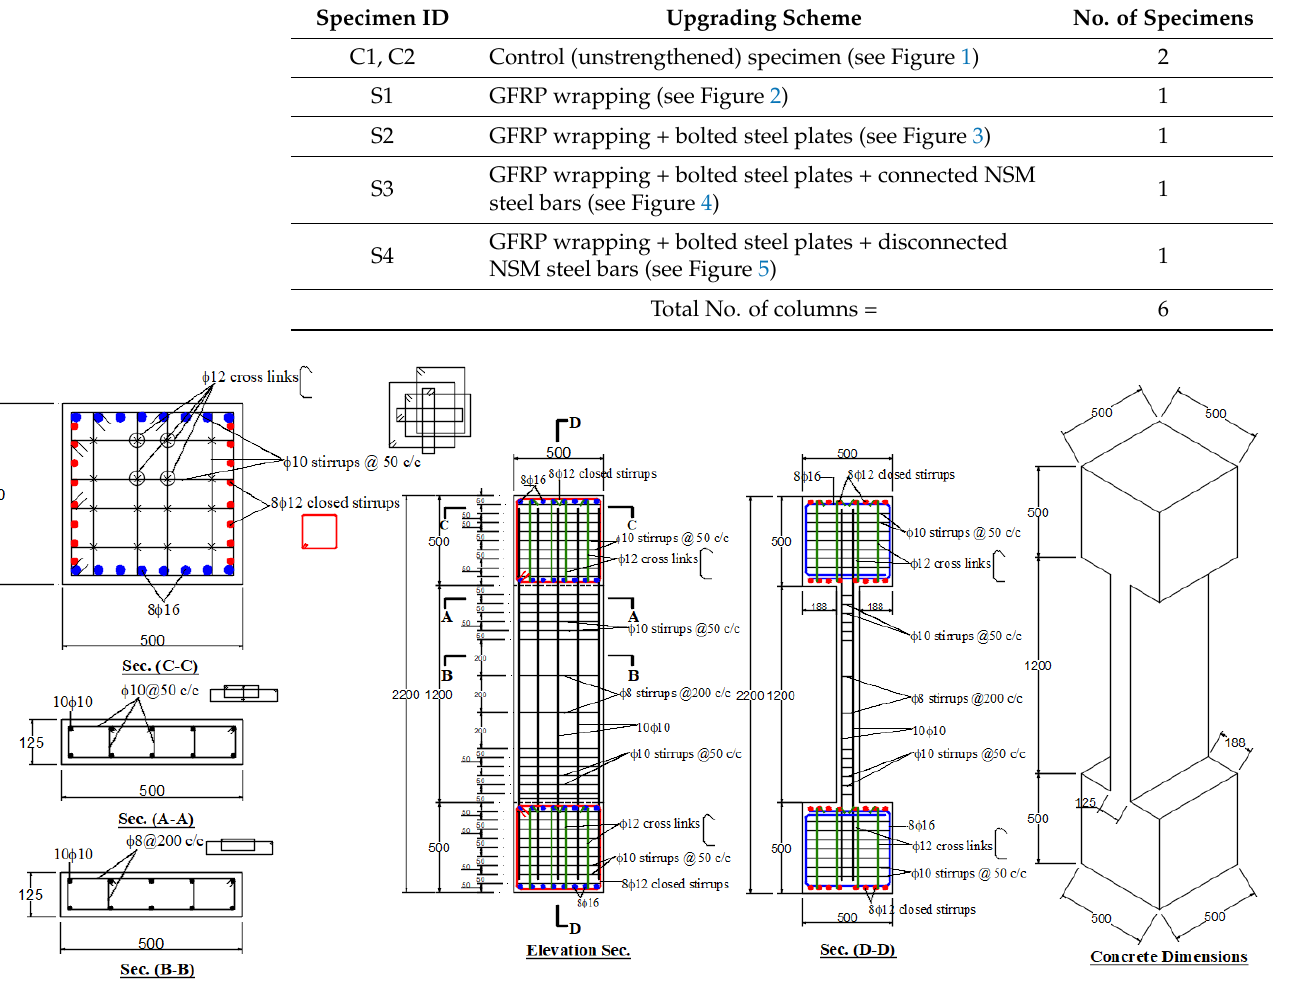
Figure 1. Details of control columns C1 and C2 (units of dimensions = mm).